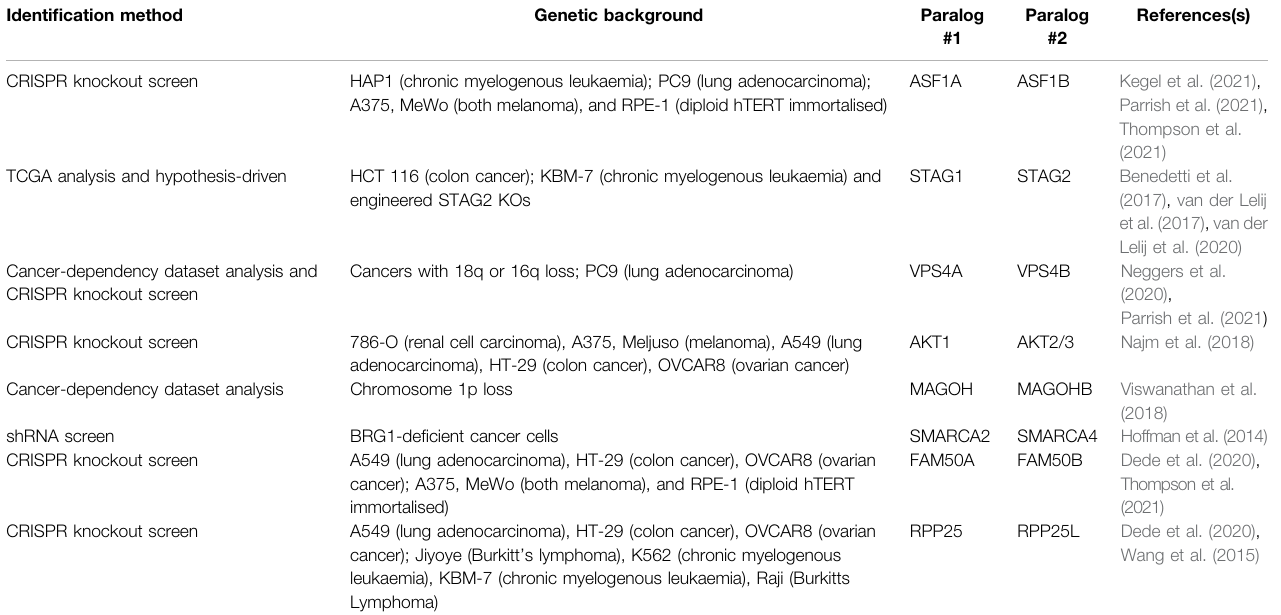
TABLE 2 | Selected paralog genetic